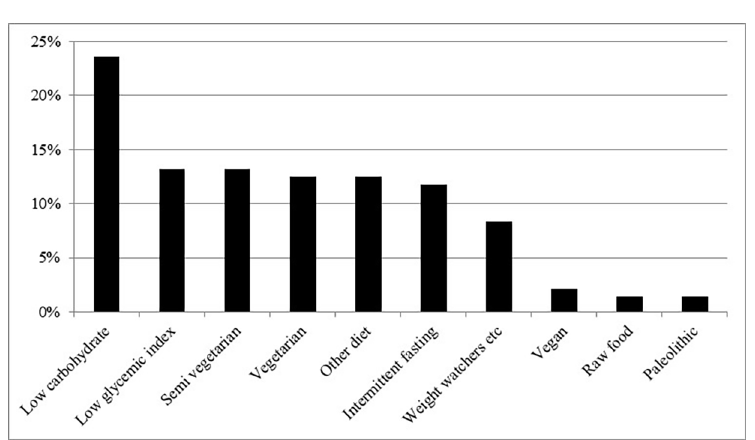
Fig 1. Prevalence of the most common dietary regimens reported in the SWEDIET-2017 survey among the 22% (N = 122) participants who claimed to follow one. SLV; Swedish National Food Agency, Other diet; Most commonly diet after gastric bypass, diabetes diet, the 8 week blood sugar diet and the Mediterranean diet.